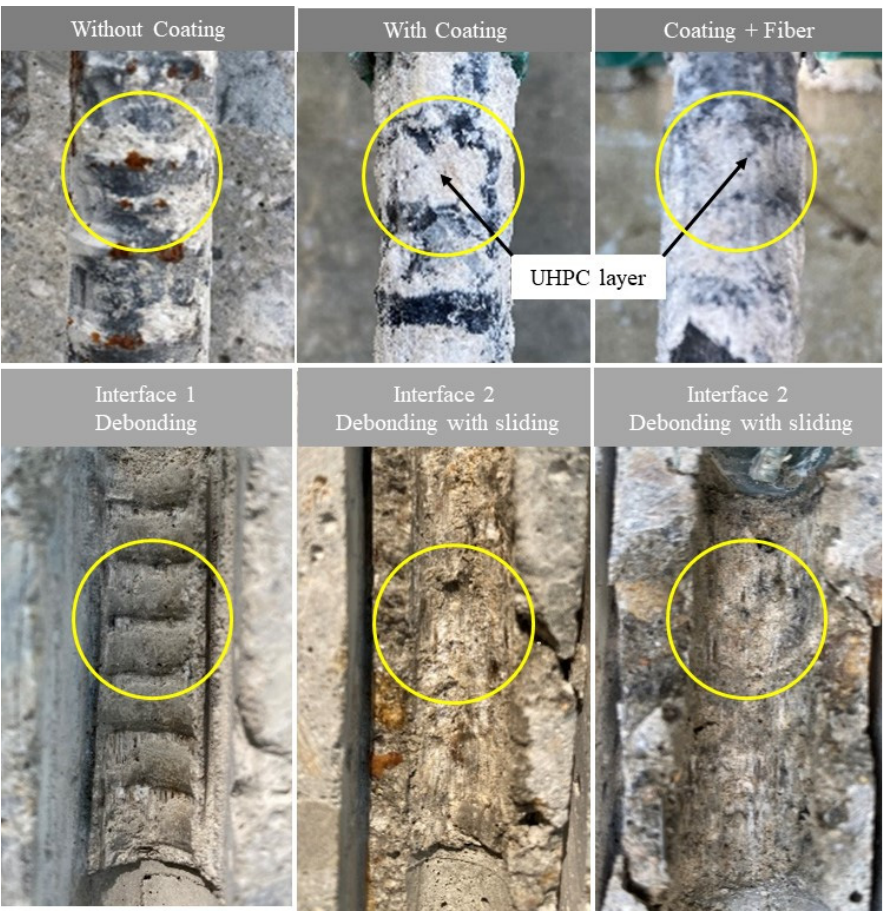
Figure 8. Examples of failure modes (interface 1 vs. interface 2).